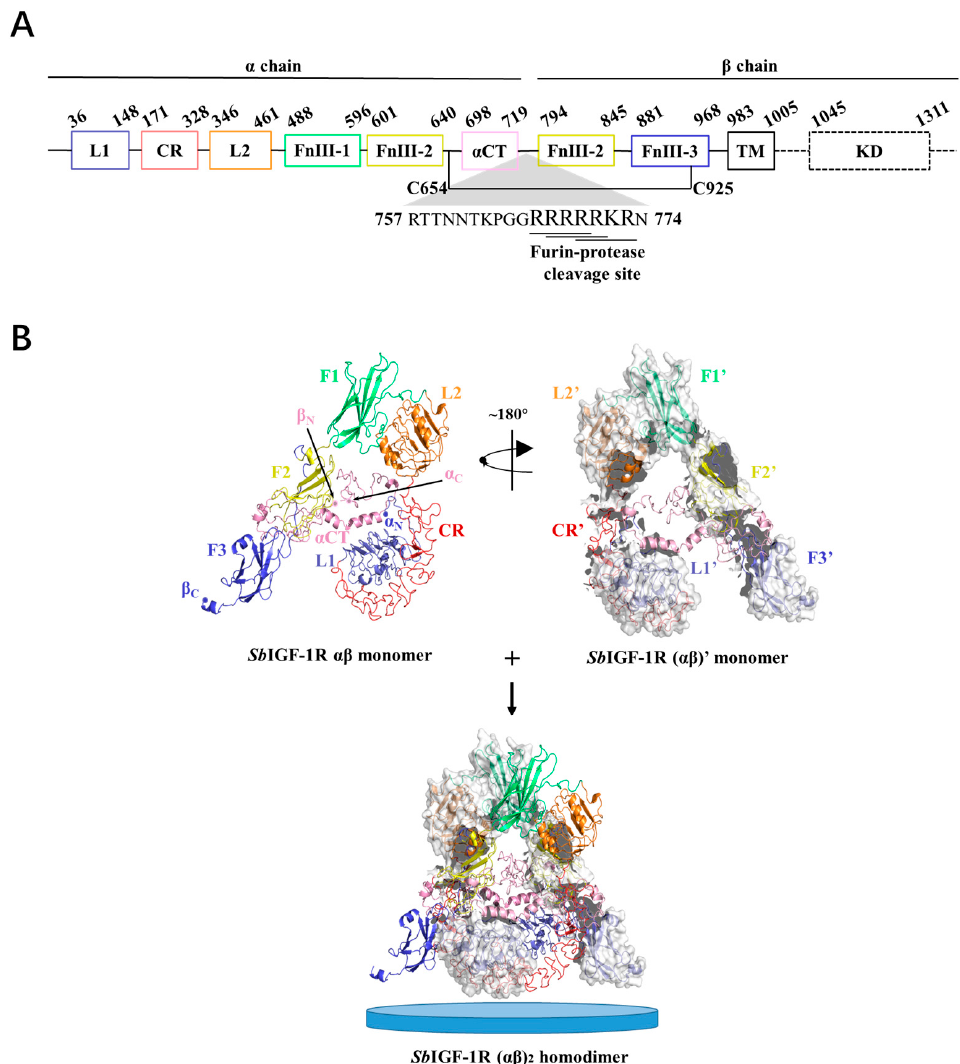
Figure 2. Three-dimensional structure of the Sb IGF-1R ectodomain. ( A ) Domain organization of Sb IGF-1R. ( B ) Overall view of the Sb IGF-1R ECD homodimer. The structure of the αβ monomer shows that it pairs with the ( αβ )’ monomer to form an ( αβ )2 homodimer. The N and C terminals of the α and β chains of Sb IGF-1R ECD are indicated as α N, α C, β N, and β C, respectively. The blue discs represent cell membranes.